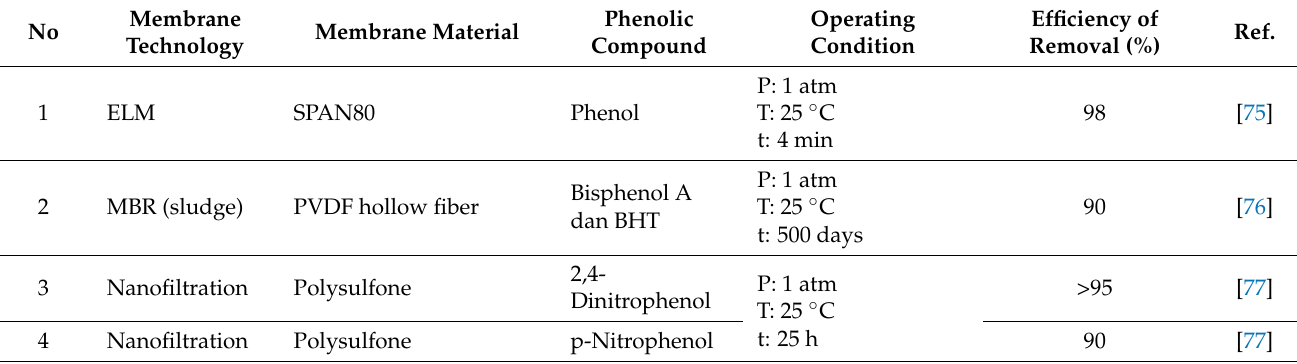
Table 8. Comparison of the efficiency for phenolic compounds removal using different types of membrane materials and membrane